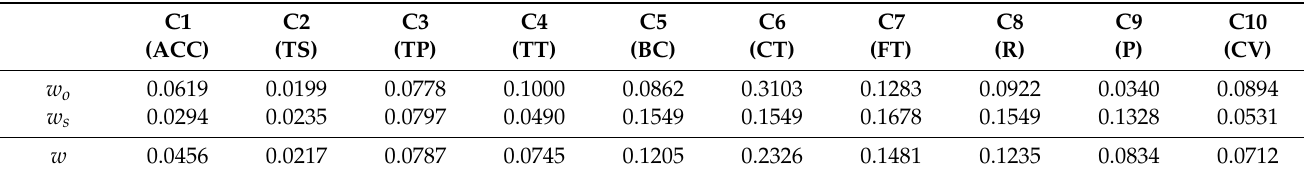
Table 7. The final weights of the criteria.